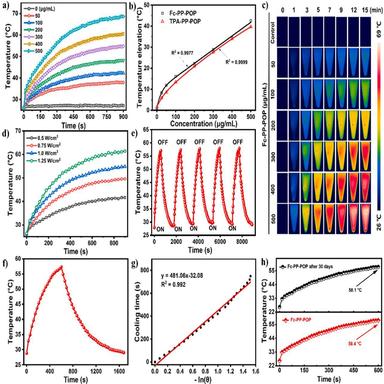
Photothermal performance of Fc-PP-POP. a) Concentration-dependent photothermal effect of Fc-PP-POP under 638 nm laser irradiation for 15 min; b) Plot of temperature change versus the concentration of Fc-PP-POP or TPA-PP-POP after exposure to 638 nm laser for 15 min; c) Corresponding infrared thermal images of Fc-PP-POP at different concentrations; d) Power-dependent photothermal effect of Fc-PP-POP under 638 nm laser irradiation; e) Photothermal profiles of Fc-PP-POP (400 μg/mL) over five cycles; f) Tempera